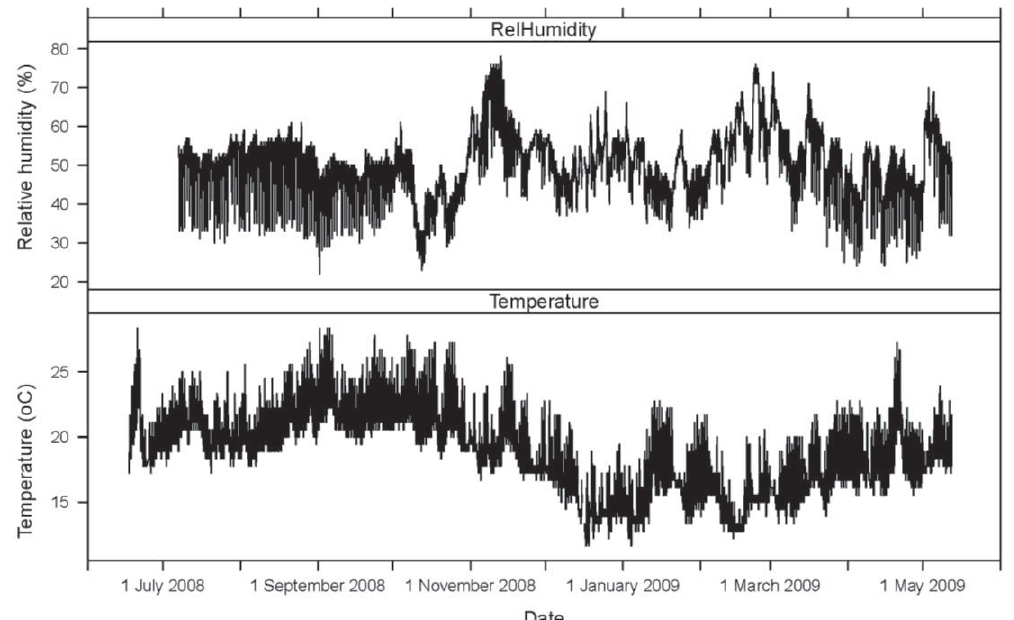
Figure 2. Temperature (°C) and relative humidity (%) traces for the building used to house the AE activity study at the University of California Richmond Field Station from 15 June 2008 to 15 May 2009.